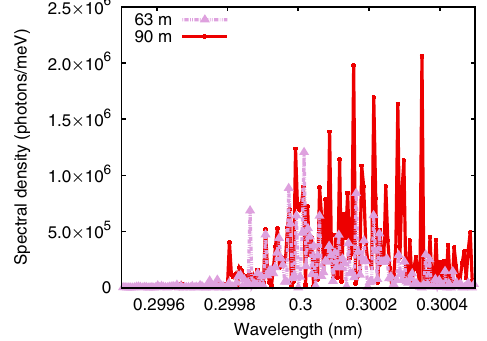
FIG. 12. Spectrum at saturation and past saturation of the (nonlinear) third harmonic for a SASE beam line tuned to a fundamental of 0.9 nm.